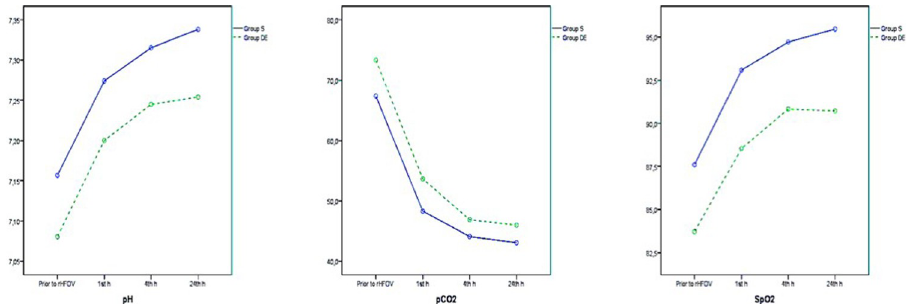
Fig 2. 2A, 2B and 2C. Changes in pH, pCO 2 and SpO 2